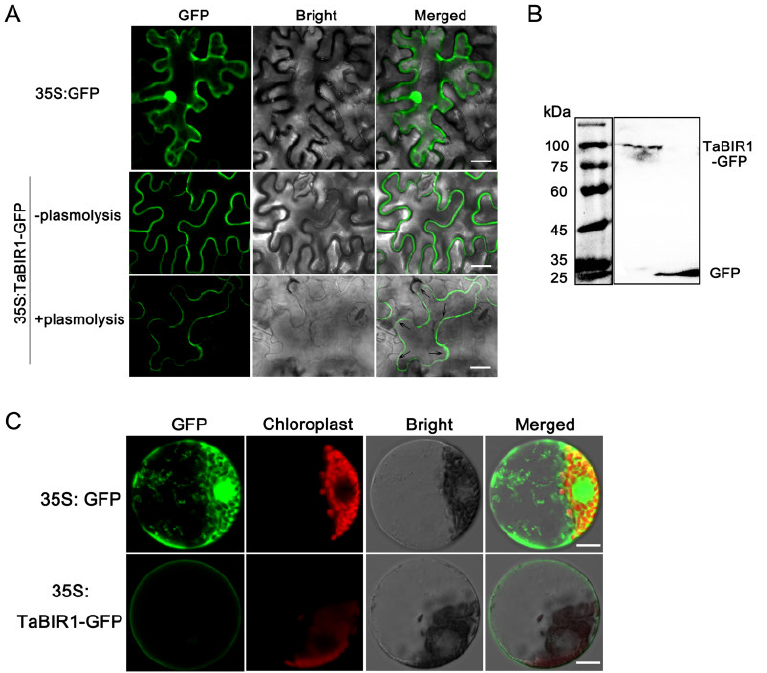
Figure 2. Subcellular localization of the TaBIR1-GFP. ( A ) Agrobacterium-mediated transient expres- sion of GFP and TaBIR1-GFP driven by 35S promoter in Nicotiana benthamiana leaves. Fluorescence was observed under confocal microscopy at 48 h post infiltration. Arrows indicate the plasma mem- brane after plasmolysis treatment. Bars, 20 µm. ( B ) Protein Western blot of TaBIR1-GFP and GFP using anti-GFP polyclonal antibody. Protein ladder marker is shown at left. ( C ) Transient expression of GFP and TaBIR1-GFP under 35S promoter in wheat mesophyll cell protoplasts using PEG-mediated transformation. Images were taken under confocal microscopy. Bars, 20 µm.